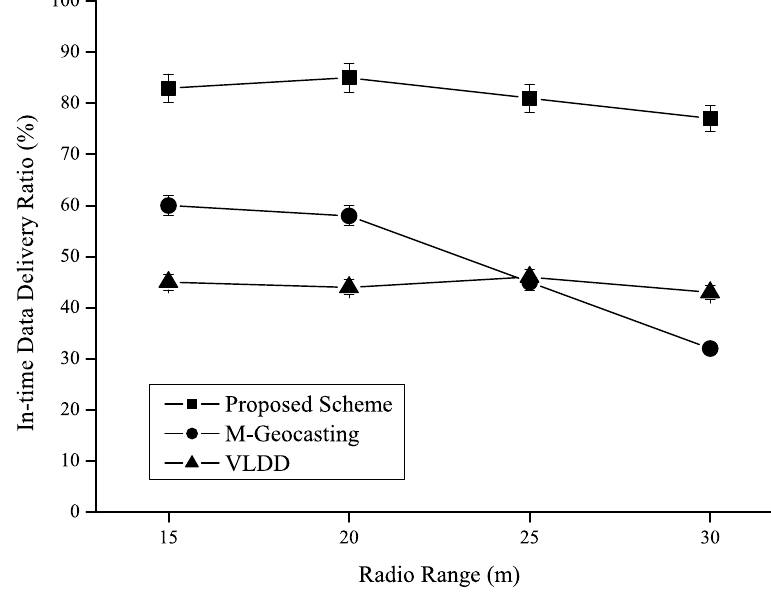
Figure 8. Comparison of total in-time data delivery ratio according to radio